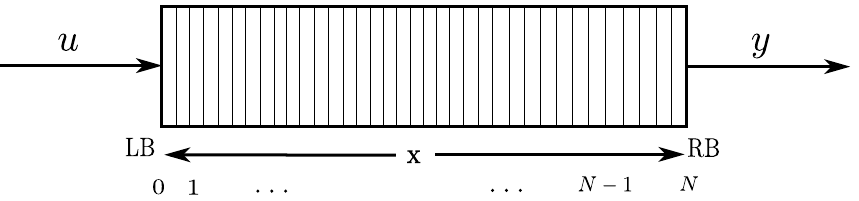
Figure 4. A standard diffusion-type boundary control problem (LB: Left boundary φ 0 ; RB: Right boundary φ N + 1 ; u: system input; y : system’s measurable output; ˆ Φ : estimated states across x ∈ [ 0, N ] : internal dimensional space of the